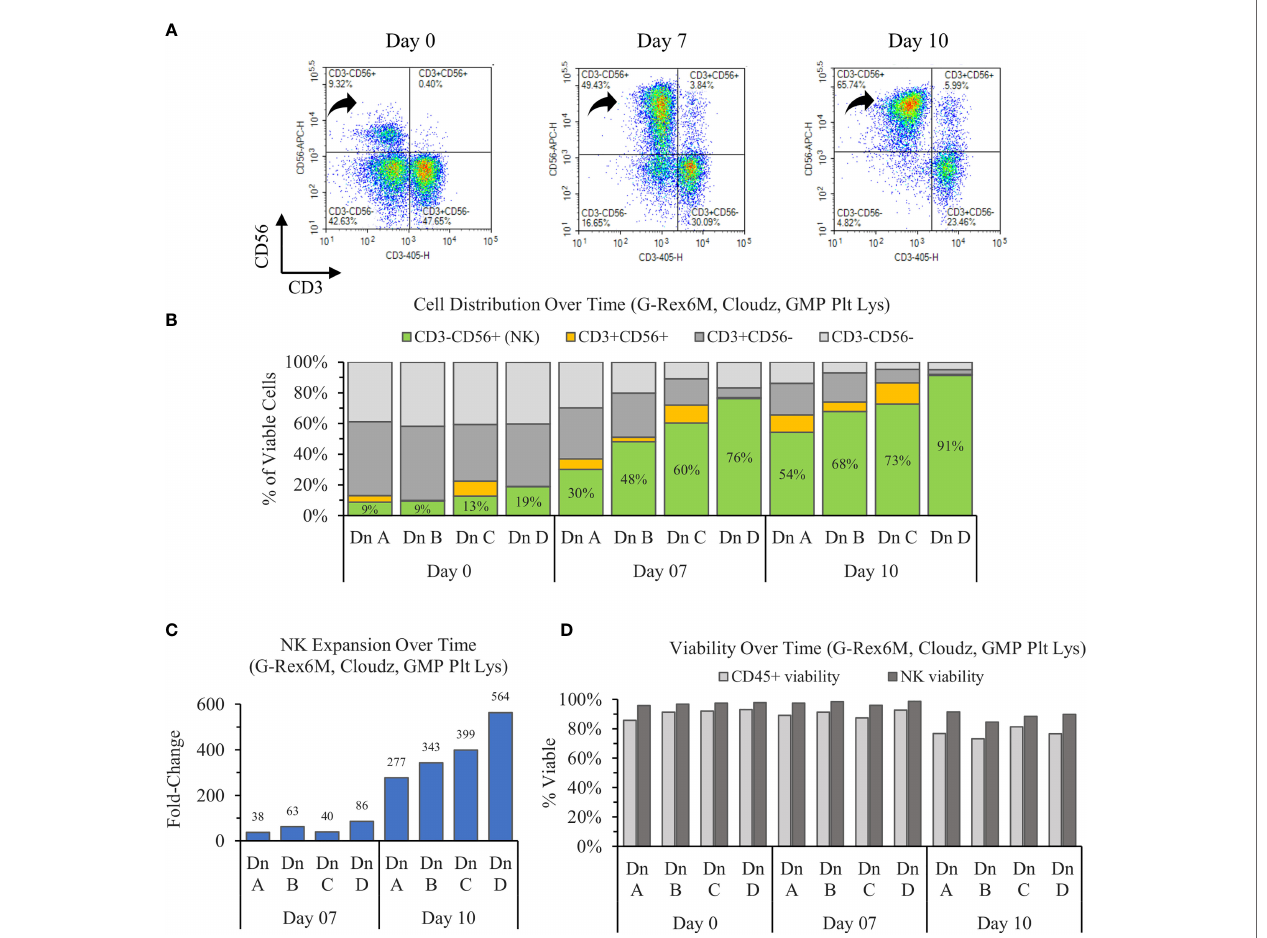
FIGURE 1 | Ten-day expansion of NK cells from PBMCs with NK Cloudz and GMP human platelet lysate cultured in the G-Rex6M. (A) Flow cytometer density plots at 0, 7, and 10 days compare CD3 and CD56 expression of the expanded cell population. Black arrows indicate CD3 − CD56 + (NK) cells, which correspond with the green boxes in (B) the plot of cell distribution of viable CD45 + cells. (C) Viable NK cell fold change relative to day 0. (D) The viability of two populations: the light gray bars represent the viability of all CD45 + cells (including NK cells) and the dark gray bars represent the viability of only the CD45 + CD3 − CD56 + (NK) population. The graphs are broken out by donor (Dn A, Dn B, Dn C, and Dn D) to highlight the donor variability in the